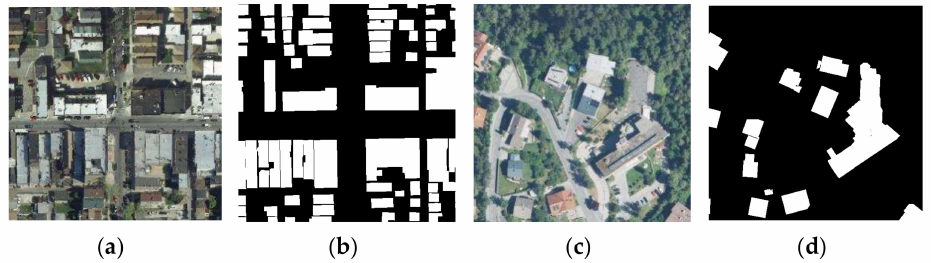
Figure 4. Image and label selected from the INRIA dataset: ( a , c ) show the image and ( b , d ) show the corresponding label in the dataset, white and black pixels mark building and non-building,